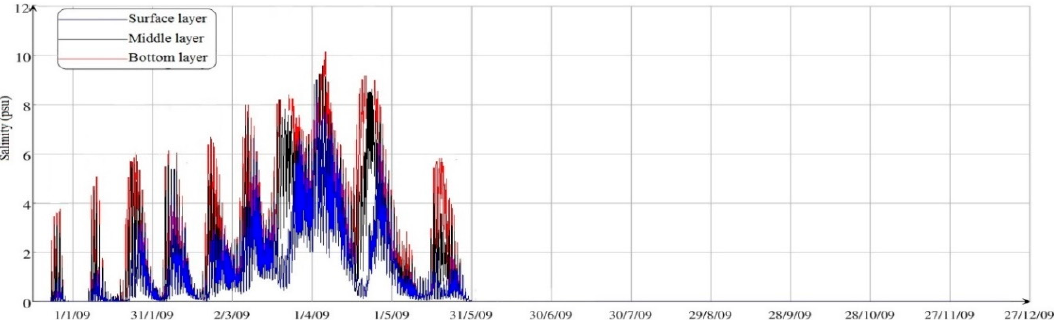
Figure 13. Time series of the distribution of salinity (psu) at station S0.